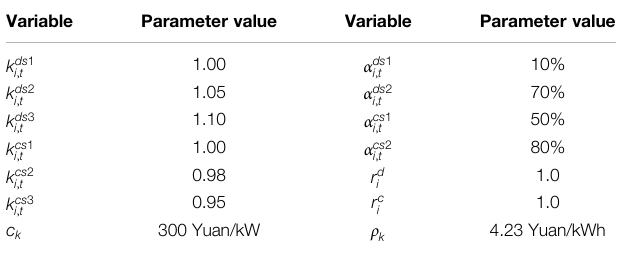
TABLE 2 | Relevant electricity price simulation